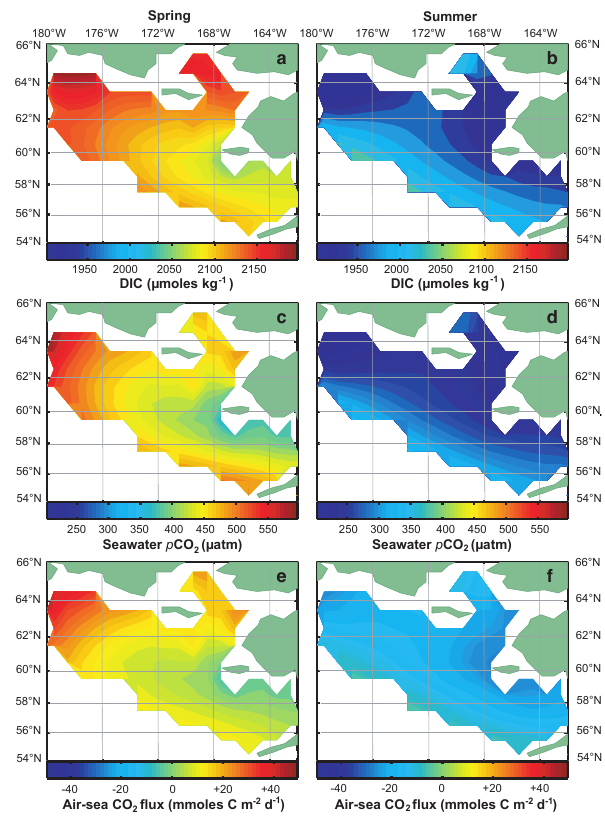
Figure 6 . Surface climatological maps of seawater carbonate properties and air-sea CO 2 flux Fig. 6. Surface climatological maps of seawater carbonate proper- determined using the MLR-based model. a . springtime DIC ( µ moles kg -1 ); b . summertime ties and air-sea CO 2 flux determined using the MLR-based DIC ( µ moles kg -1 ); c . springtime seawater p CO 2 ( µ atm); d . summer seawater p CO 2 ( µ atm); e . springtime air-sea CO 2 flux (mmoles m -2 d -1 ); f . summertime air-sea CO 2 flux (mmoles m -2 d - 1 ).